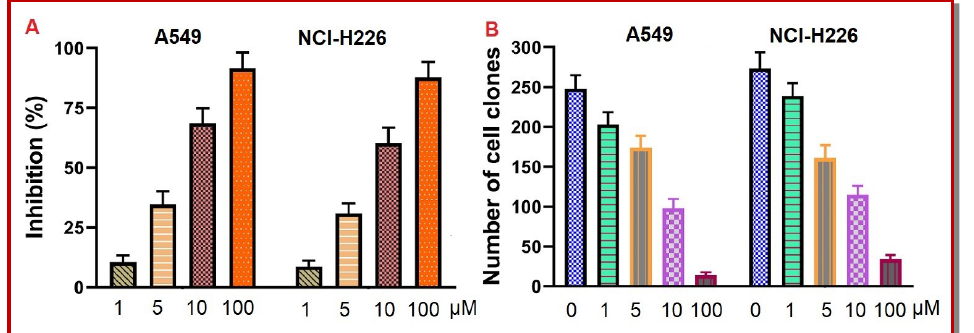
Figure 1: Effects of mulberrofuran G on the proliferation of A549 cells and NCI-H226 cells. (A) CCK8 assay; (B) Cell colony